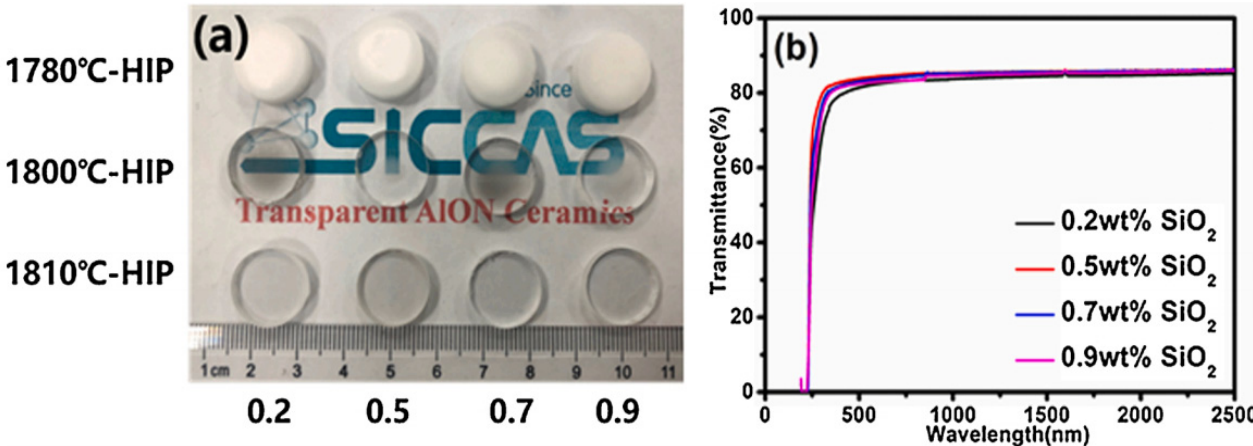
Figure 13. Samples and transmittance curve; ( a ) samples doped with different SiO 2 contents and different temperatures in the process of HIP; ( b ) transmittance of AlON transparent nano-ceramics doped with different SiO 2 contents at 1810 °C for 3 h [92]. Reprinted with permission from Ref. [92]. Copyright 2021, copyright ScienceDi rect .